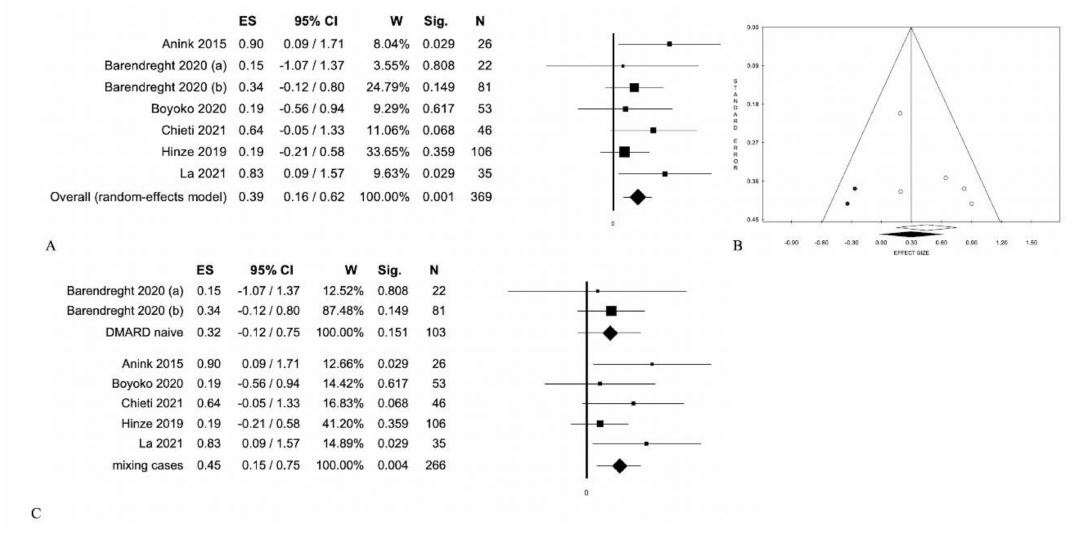
Figure 4. Subjects with any form (active/non active; systemic/non systemic) vs. healthy controls: ( A ) Forest Plot; ( B ) Funnel Plot.